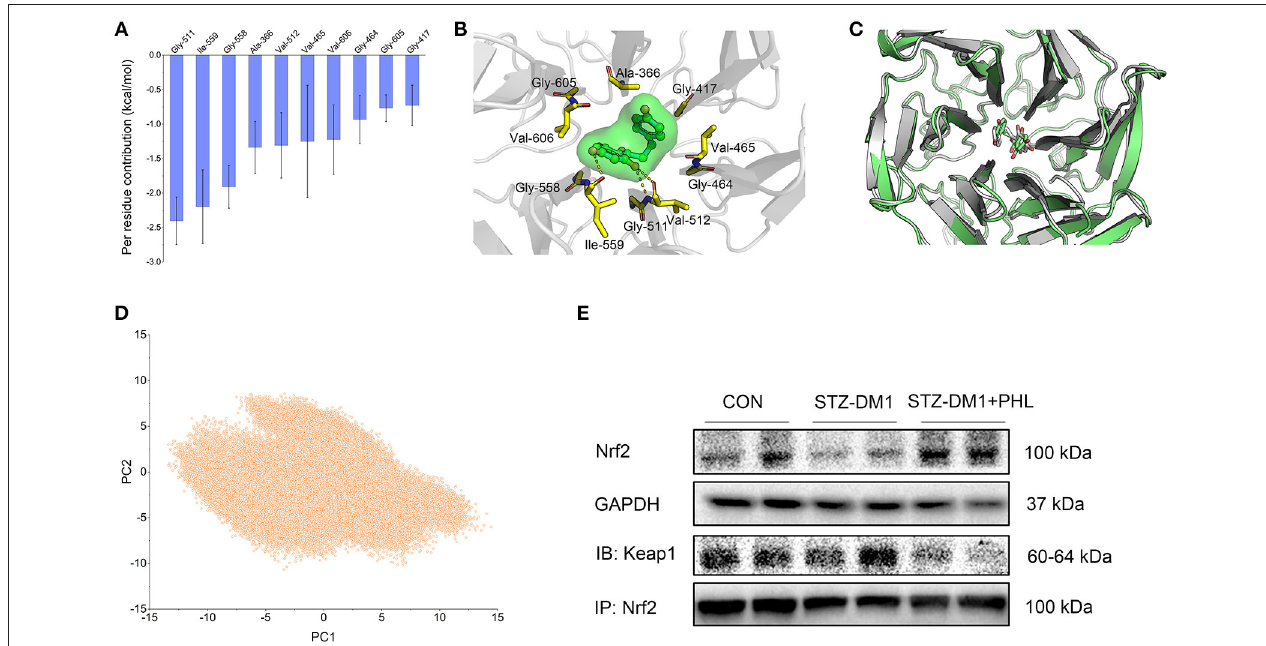
FIGURE 6 | PHL targeted Keap1 to disassemble the Keap1/Nrf2 complex. (A) Per-residue of top 10 contribution to the binding free energy; (B) Structural analysis of the most 10 contributors of Keap1 to PHL, hydrogen bonds are colored yellow; (C) Alignment of the representative structures between from conventional MD simulation and from GaMD simulation; (D) PCA scatter plot of 200,000 snapshots from GaMD simulation along the first two principal components. (E) Immunoblotting analysis of Nrf2 expression and Co-Immunoprecipitation analysis of Nrf2 and Keap1 complex in lysates prepared from heart tissues. GAPDH was used as a loading